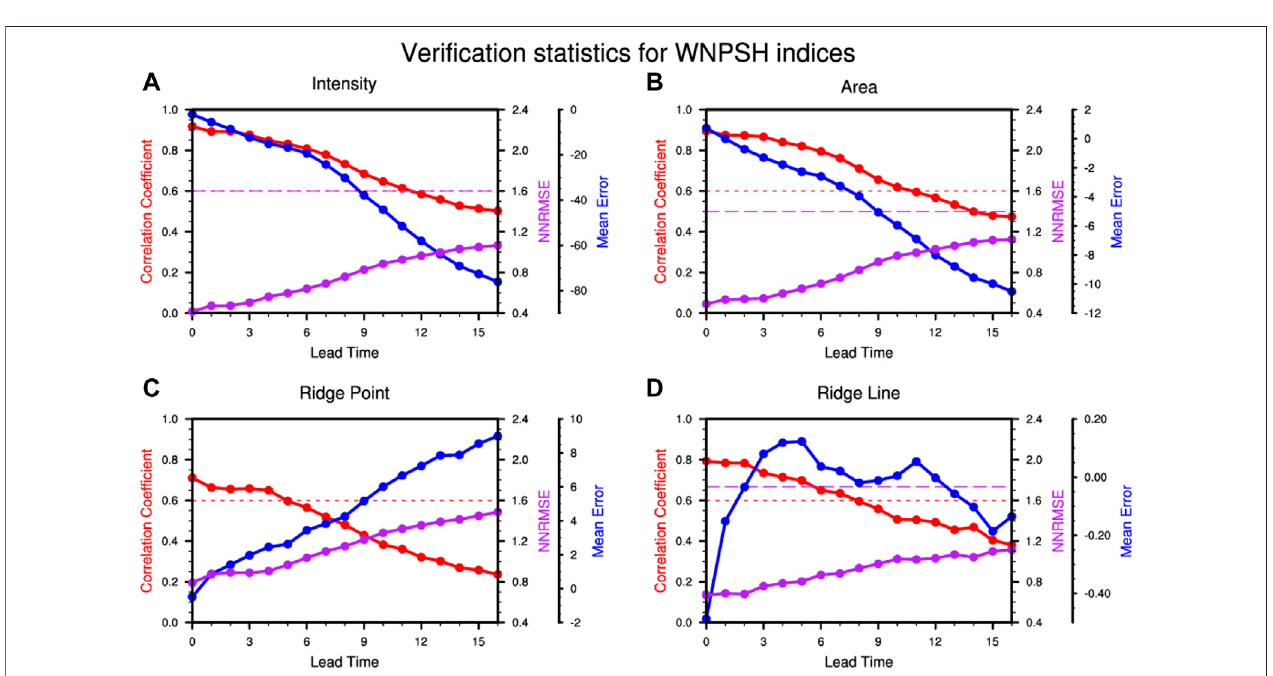
FIGURE 3 | Same as Figure 2 , but for reforecasts after the bias correction in terms of Eq. 5 .